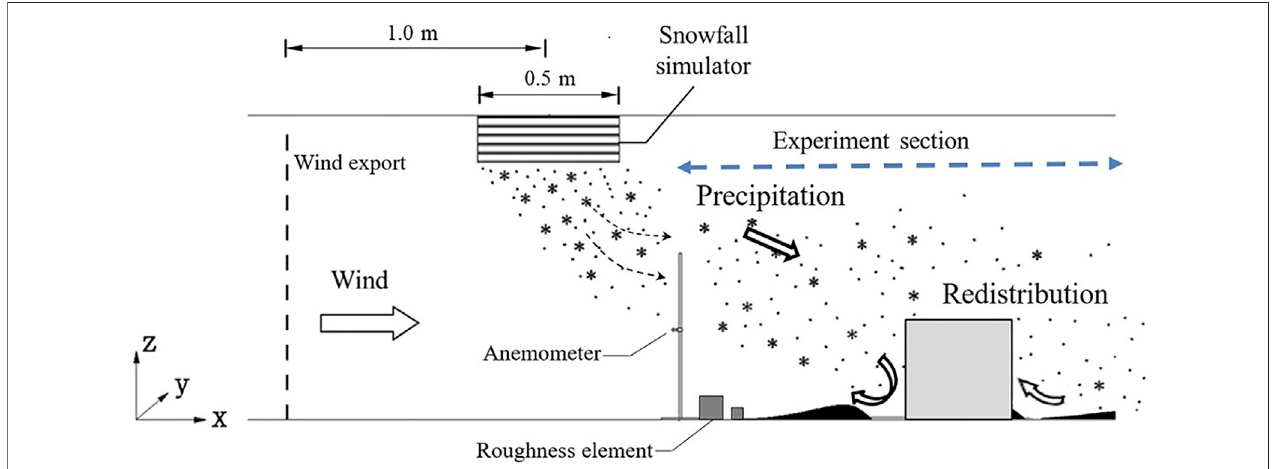
FIGURE 5 | Schematic view of the cube model experiment setup in the snow – wind combined experiment facility.